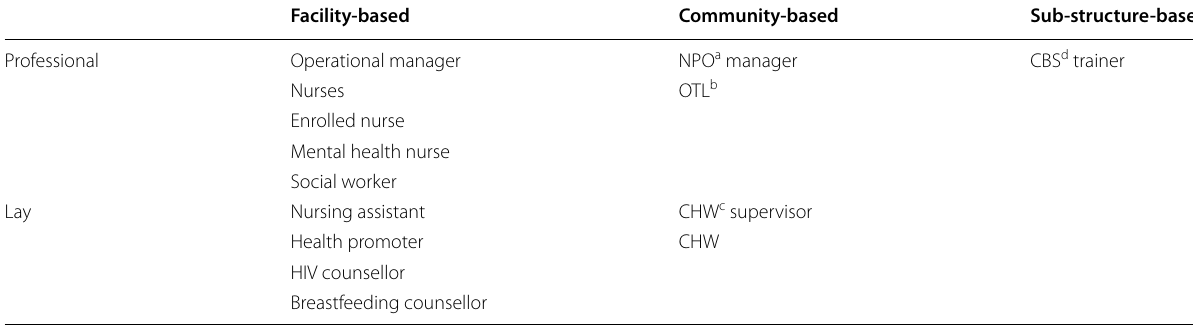
Table 1 Classification of health workers according to level of qualification and